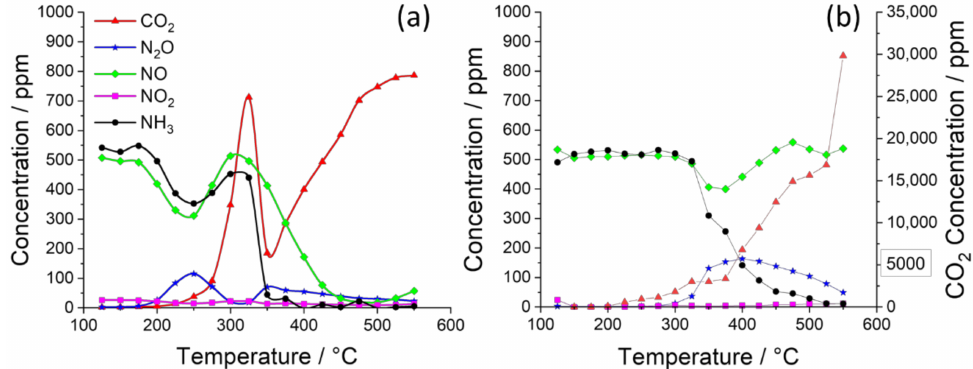
Figure 3. Performance of 2%Ag–20%K/CZA tested in a simulated exhaust gas containing NH 3 as reductant ( a ) in the absence of carbon black, and ( b ) in the presence of carbon black. This figure contains data from a previous publication [14]. 2020,